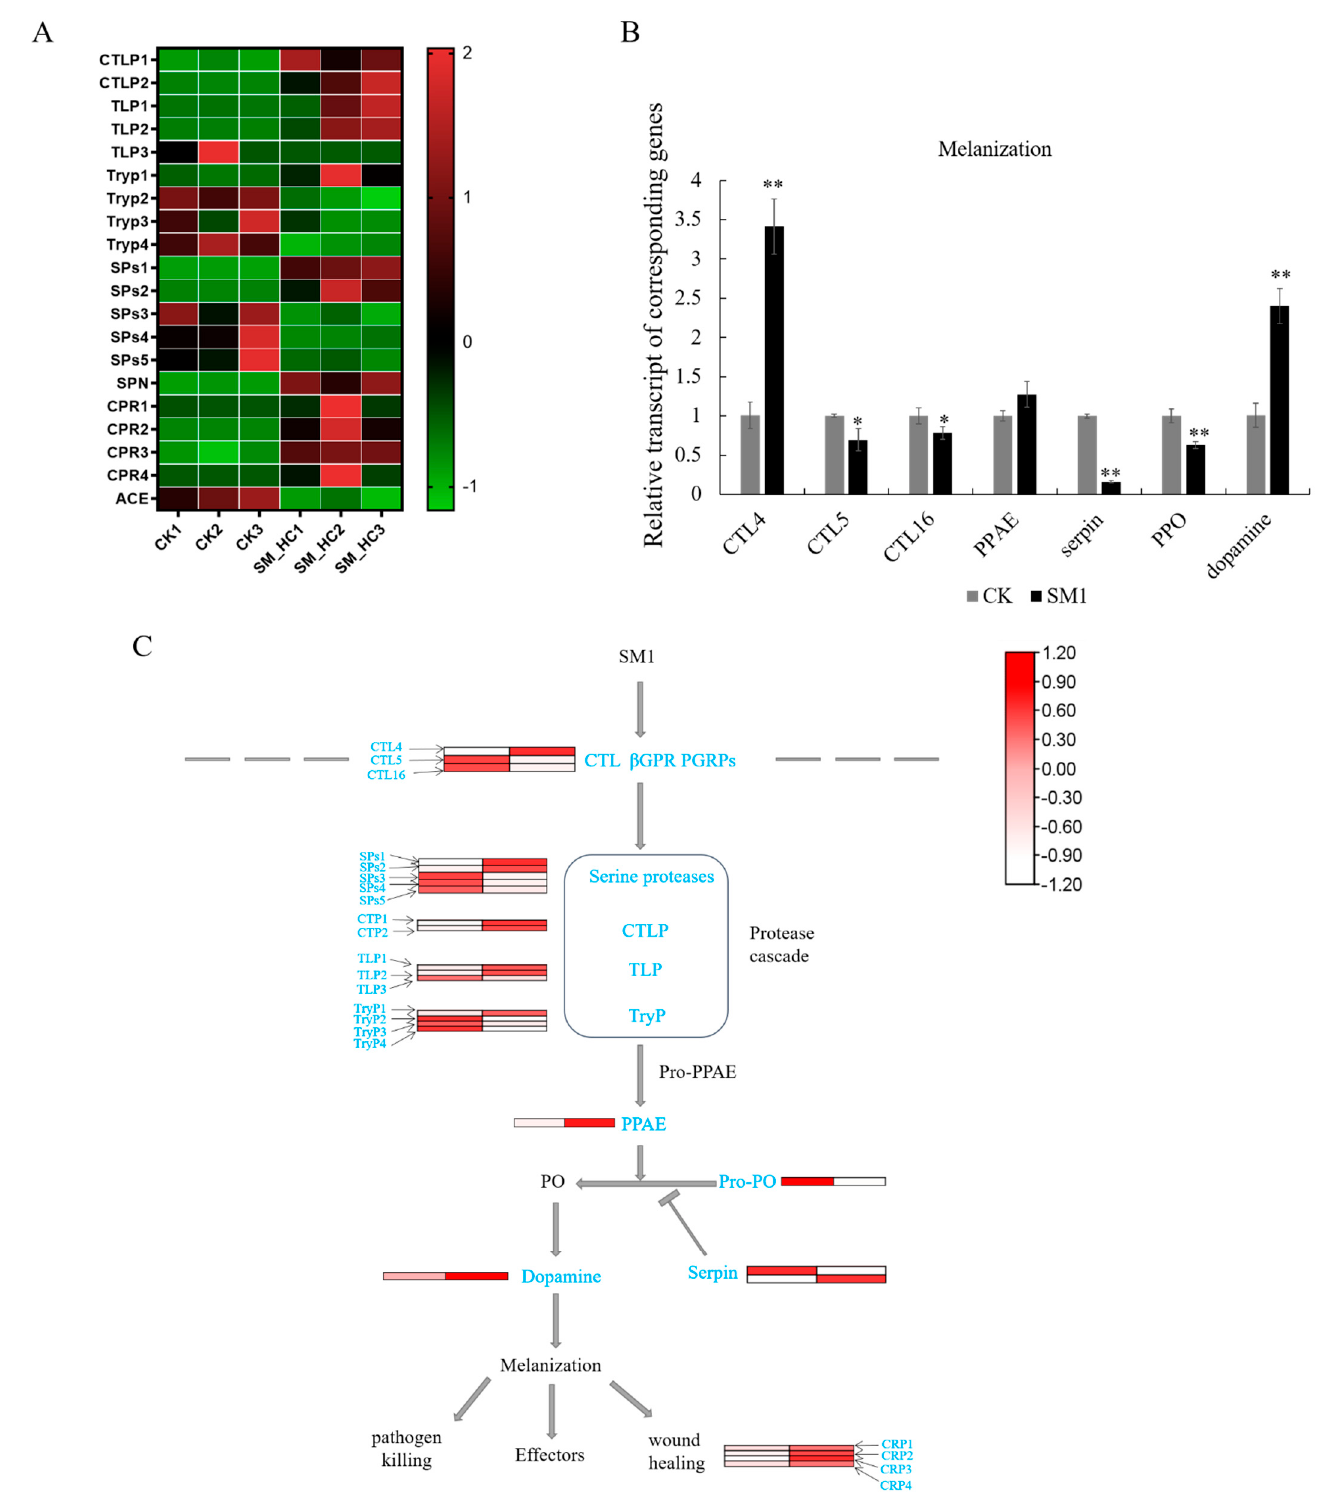
Figure 4. Changes in the regulatory patterns of the melanization in H. cunea infected by SM1. ( A ) Heatmap clarifying the differences in biochemical pathway genes in melanization using transcriptome data. CK1, CK2 and CK3: the control groups. SM-HC1, SM-HC2 and SM-HC3: H. cunea groups infected with SM1. ( B ) The expression profile of genes in melanization in H. cunea infected with SM1 and the control using RT-qPCR. ( C ) Diagrammatic sketch of melanization in H. cunea integrated the results in ( A , B ). Significantly differentially expressed genes are shown in blue. p < 0.05 (*) was considered significant, and p < 0.01 (**) was considered very significant.